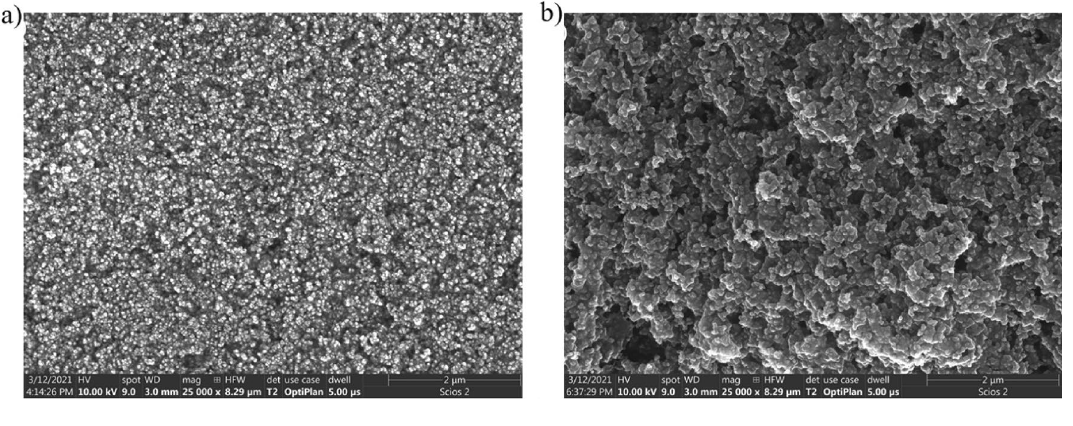
Figure 4. SEM images of ( a ) sample A ; ( b ) sample B